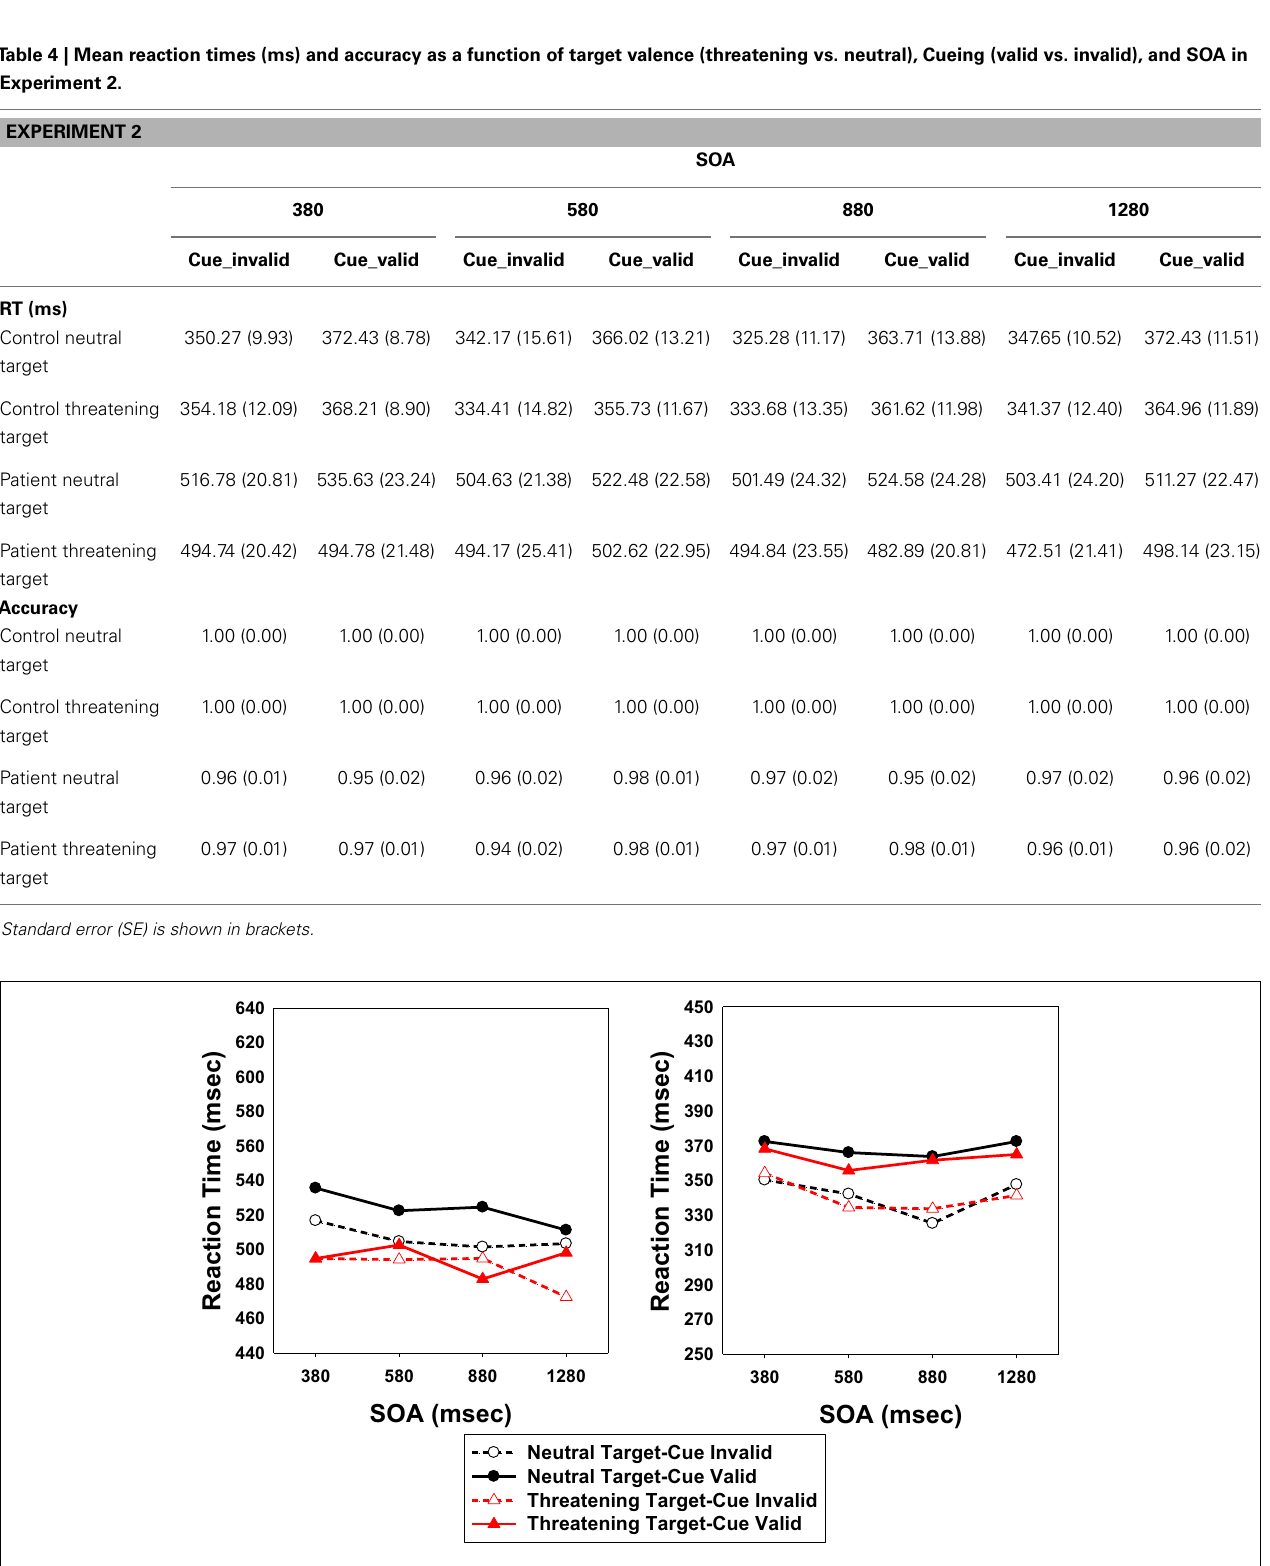
FIGURE 3 |Target detection times of Experiment 2, broken down by Cueing (cued vs. uncued location),Target valence (threatening vs. neutral), and Stimulus OnsetAsynchrony (SOA) . Left panel: patient group; right panel: control